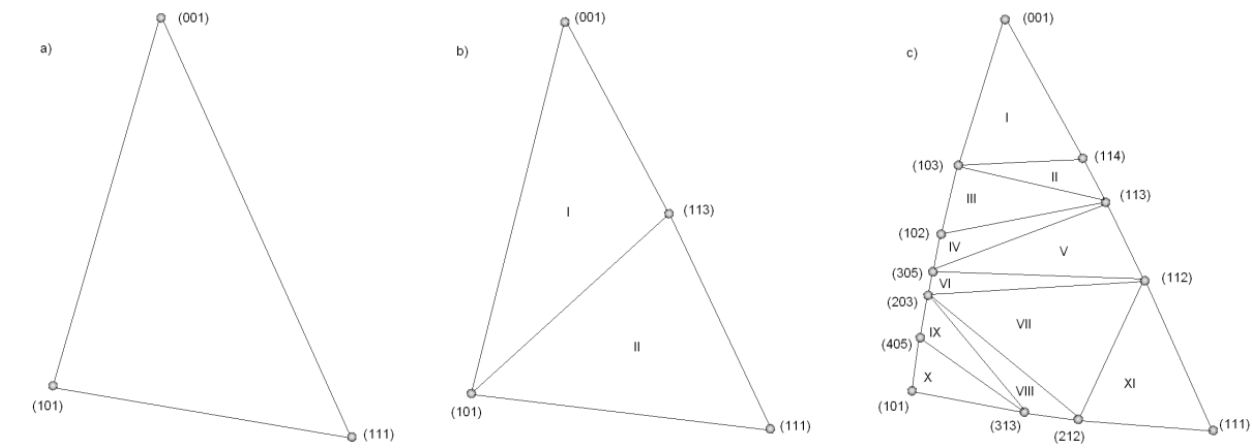
Figure 2. The (a) three- , (b) four- and (c) thirteen-parameters inetrpolation